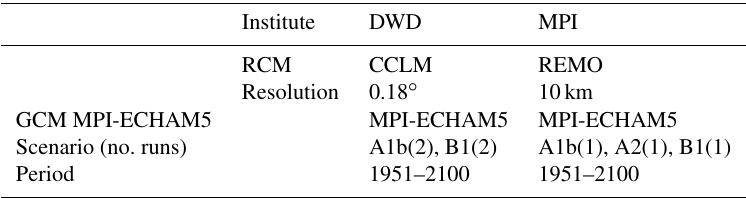
Table A1. Scenario data matrix used in Hattermann et al. (2014).